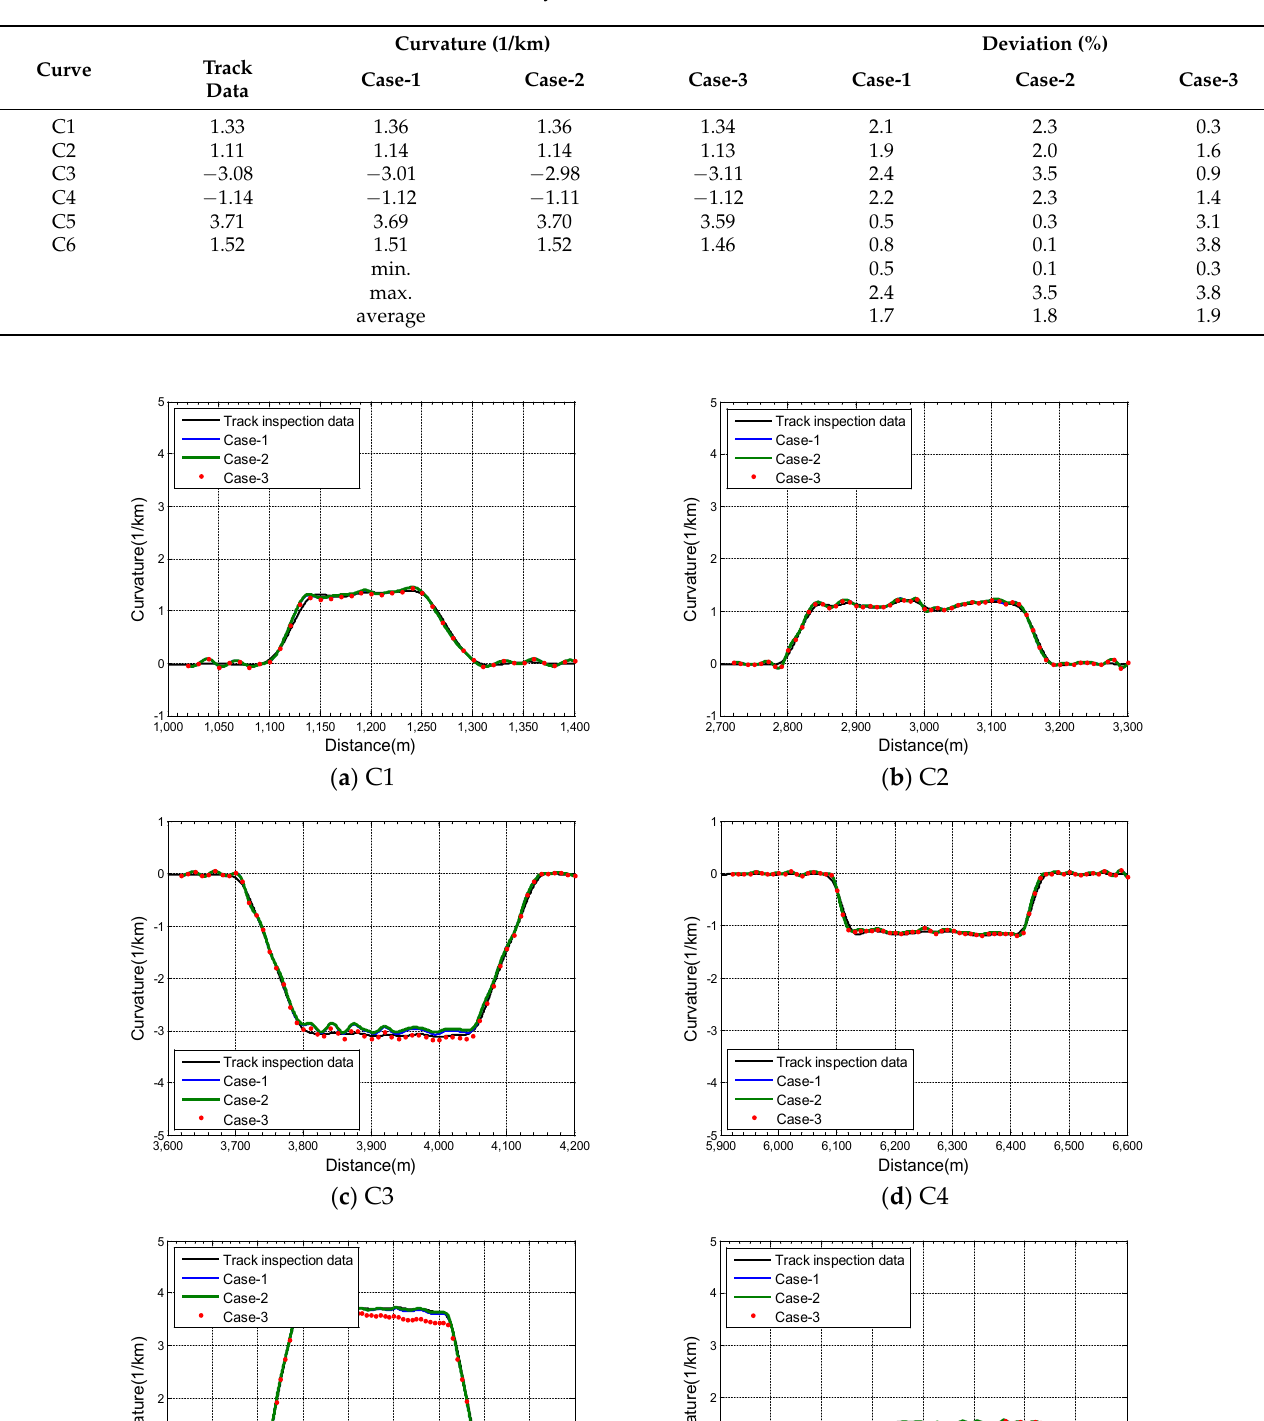
Table 1. Curvature analysis results.